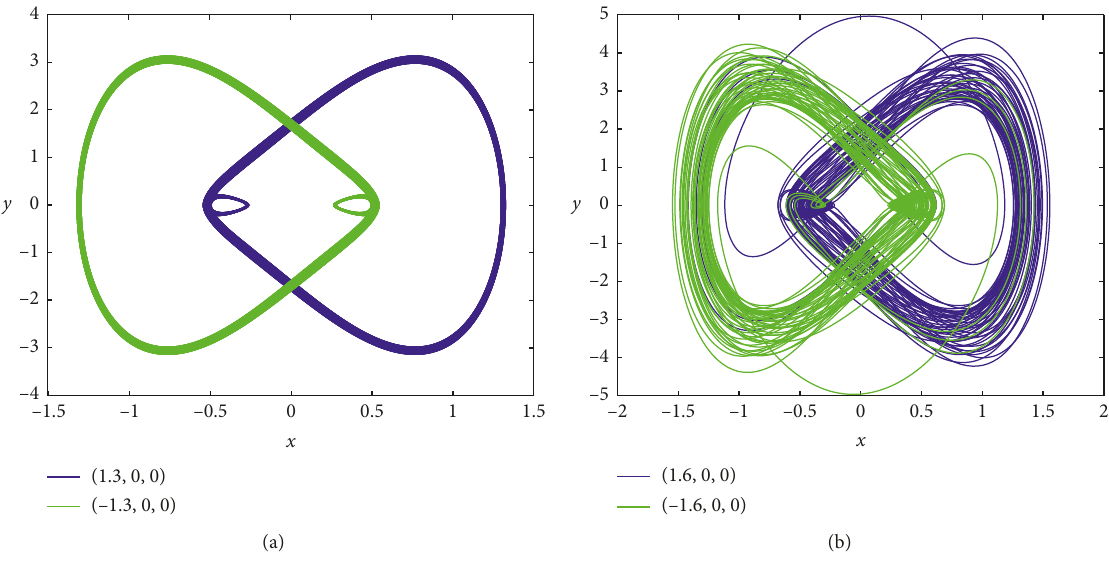
Figure 7: Symmetric coexisting attractors with respect to x ( 0 ) . (a) Period with x ( 0 )� 1.3 and − 1.3; (b) chaos with x ( 0 ) � 1.6 and − 1.6.